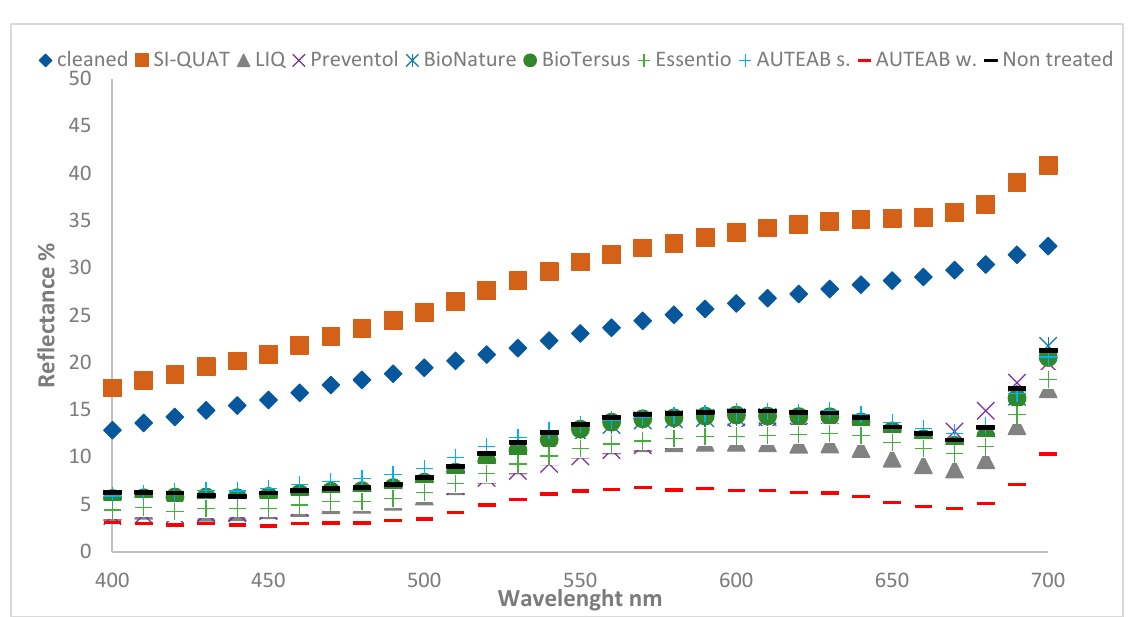
Figure 3 . Full spectrum color measurement of the treated zones in Area 1. Standard deviation 0.5 < SD < 3.2.